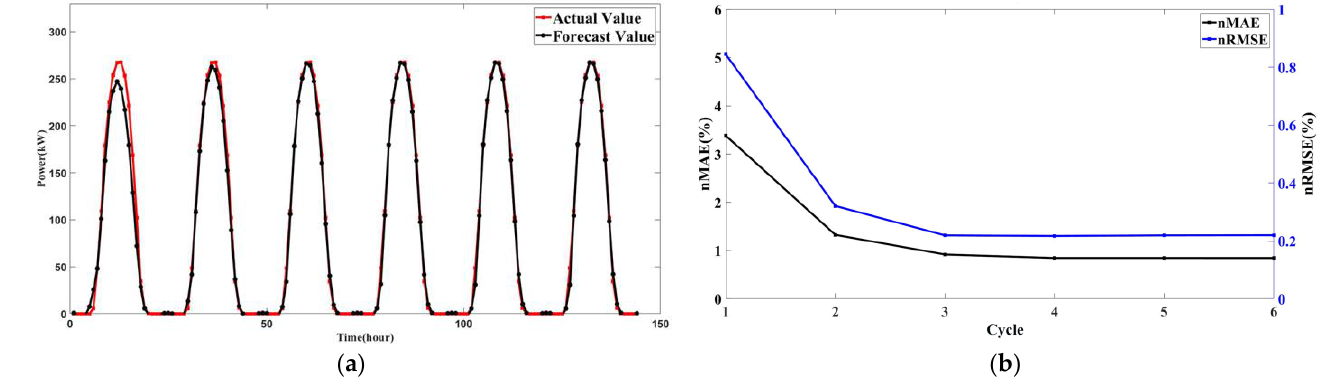
Figure 14. Verification of proposed model with on-line learning ability: ( a ) six consecutive cycles of power generation forecasting; ( b ) variation in nMAE and nRMSE values.